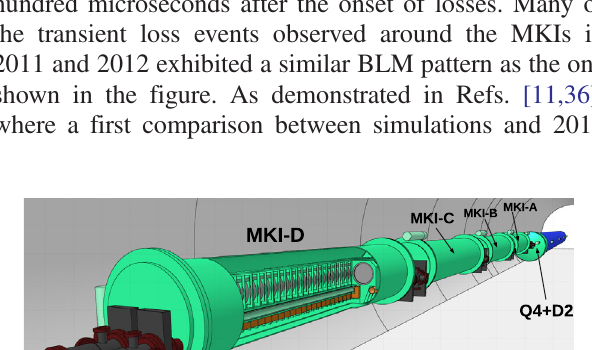
FIG. 11. Comparison of simulated BLM signals with measured BLM patterns attributed to dust-particle-induced beam losses in a standard LHC arc cell (19R3). All patterns are expressed as a fraction of the maximum signal. The beam direction is from the left to the right. The events occurred during regular 4 TeV proton fills in 2012. The vertical arrows indicate the dust particle positions assumed in the simulations. The statistical error of the simulation results is less than 10%, except for BLMs signals, which are less than 10 − 2 of the maximum signal. BLMs upstream of the loss location, which measure the backscatter component of particle showers.